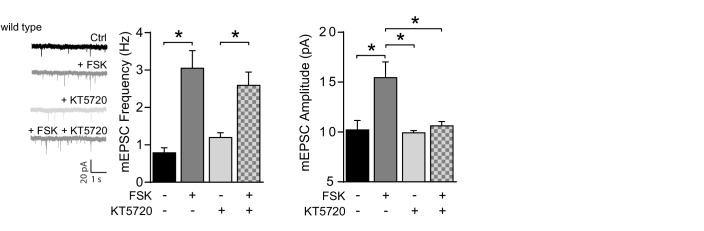
PKA-inhibitor KT5720 prevents the forskolin driven increase in mEPSC amplitude, but not frequency.Untreated wild-type CA1 neurons (n=7), neurons incubated with forskolin (n=8), with PKA inhibitor KT5720 (n=10), preincubated with KT5720 prior to forskolin (n=10). KT5720 blocked the forskolin-driven increase in mEPSC amplitude (ANOVA, ctrl vs FSK: p=0.0002; KT5720 vs KT5720/FSK: p=0.8; FSK vs KT5720/FSK: p=0.005), but not mEPSC frequency (ANOVA, ctrl vs FSK: p<0.0001; KT5720 vs KT5720/FSK: p=0.005; FSK vs KT5720/FSK: p=0.9). Error bars indicate SEM, * indicates p<0.05.